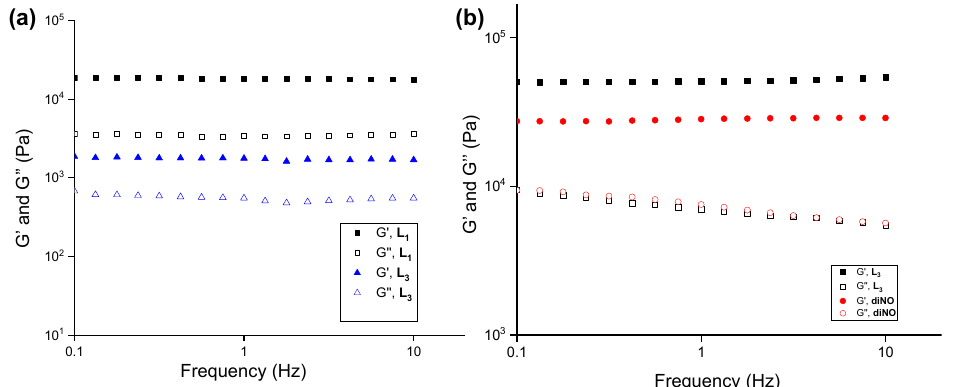
Figure 1. Frequency-sweep experiments performed on ( a ) L 1 and L 3 gels at 2.0 wt% and ( b ) L 3 and diNO gels at 4.0 wt% in water at a constant strain of 0.02% at 20.0 °C, respectively.